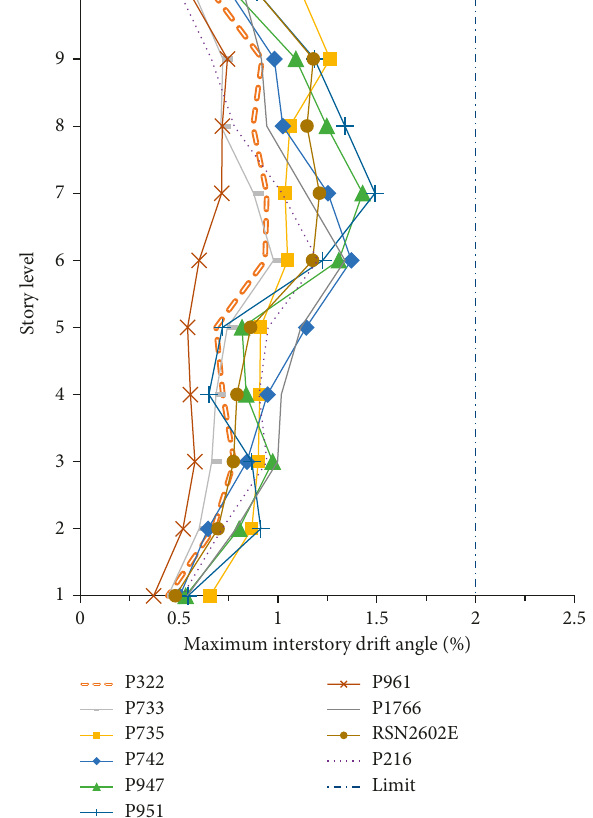
Figure 11: Maximum interstory drift angles of 10-story